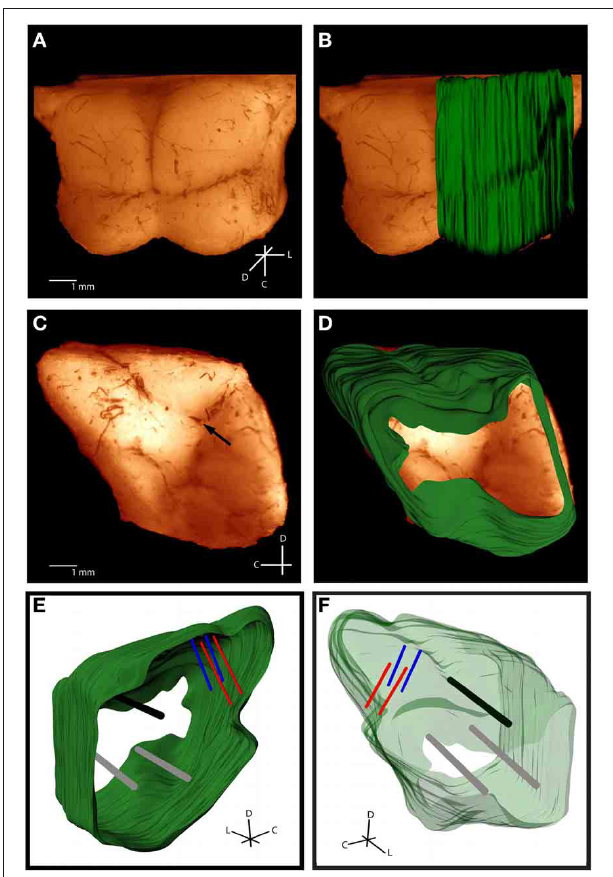
FIGURE 3 | Histological computer reconstruction of the midbrain overlaid on a top view (A,B) and lateral view (C,D) of the fixed midbrain. Images were digitally enhanced to improve visualization of the borders. The reconstructed midbrain was also slanted in A and B to align it with the angled view of the fixed midbrain, which was purposely presented in this way to visualize the lateral side of the right inferior colliculus. The placement of the “consistent reference track,” which is through the intersection of the superior colliculus, thalamus, and lateral extension from the inferior colliculus, is indicated by the black arrow in (C) . Computer reconstructions are rotated to view them from the medial (E) and lateral (F) sides. The consistent reference track is shown in black, the two arbitrarily-placed reference points are in gray, and the two bi-shank probe pairs are in red and blue. C, caudal; D, dorsal; L,